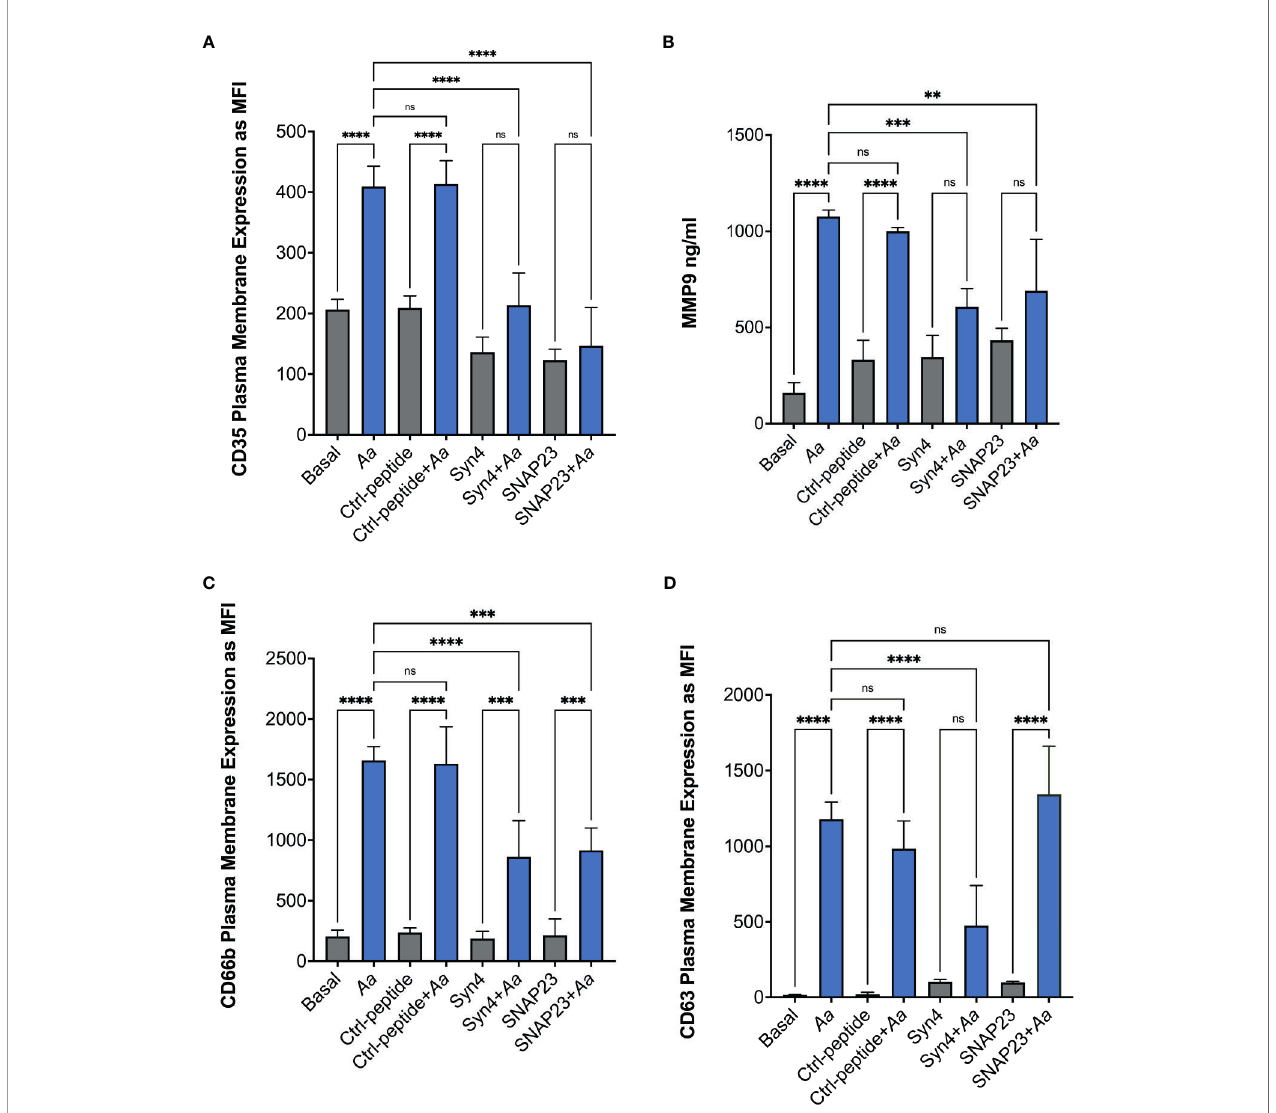
FIGURE 4 | Pre-treatment with TAT fusion proteins prevented A. actinomycetemcomitans- induced neutrophil granule exocytosis. Human neutrophils were unstimulated, challenged with A . actinomycetemcomitans (Aa) at MOI 50, or pre-treated with TAT-Syntaxin 4 (Syn4), TAT-SNAP23 (SNAP23), and TAT-Control peptide (Ctrl-peptide) for 15 min followed by A . actinomycetemcomitans challenge. The peak time point of Aa -induced granule exocytosis was different for each granule subtype. Secretory vesicle peak was at 15 min post-bacterial challenge (A) , 2 h for gelatinase granules (B) , 4 h for speci fi c granules (C) , and 8 h for azurophilic granules (D) . Granule markers were measured by fl ow cytometry and plotted as the mean channel fl orescence intensity (MFI) ± SEM of four independent experiments (A, C, D) . For gelatinase granules, matrix metallopeptidase 9 (MMP-9) was measured from human neutrophil supernatant by ELISA and MMP-9 concentration is plotted as the mean ± SD of four independent experiments (B) . Statistical differences among experimental conditions were analyzed by ordinary one-way ANOVA, followed by Tukey ’ s post-test. ns, not signi fi cant, ** p < 0.01, *** p < 0.001, **** p <